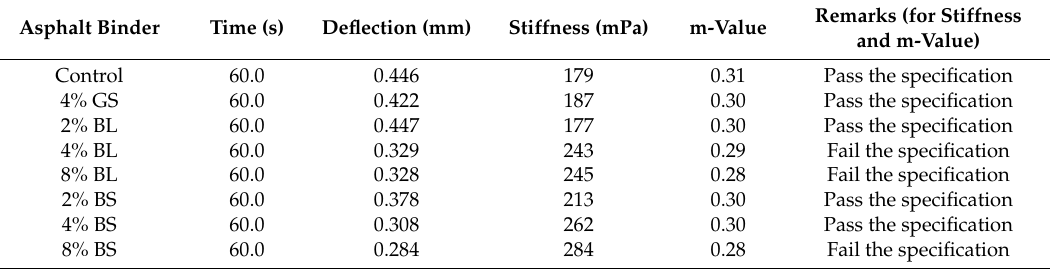
Table 4. The Bending Beam Rheometer (BBR) results of control, graphite modified and bio-char modified asphalts at − 18 ◦